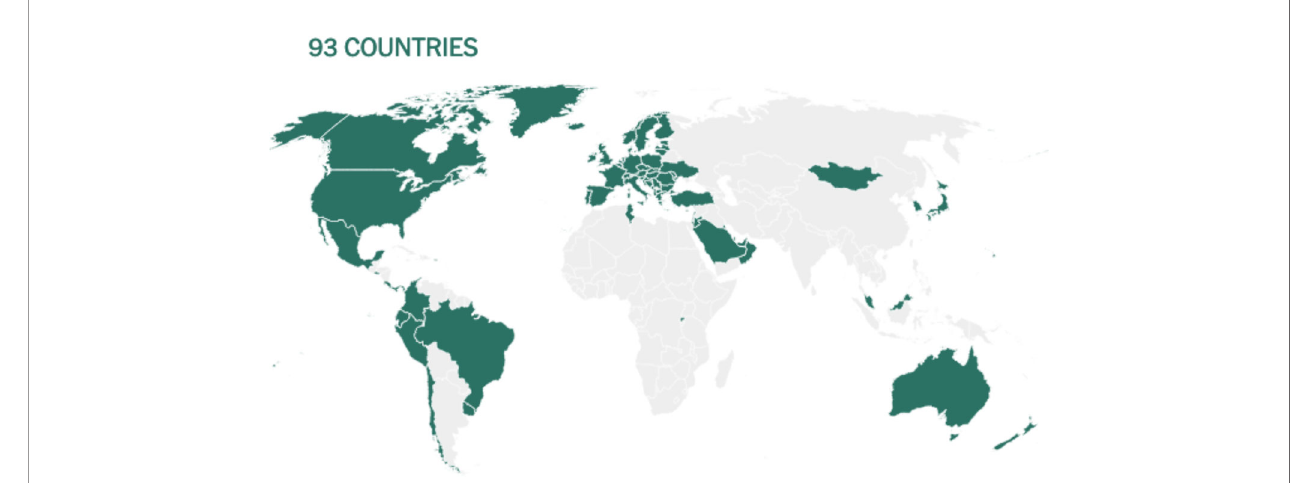
FIGURE 9 | Countries where the Cominarty (P fi zer-BioNTech) vaccine is being used as of May 10, 2021. Source: Our World in Data